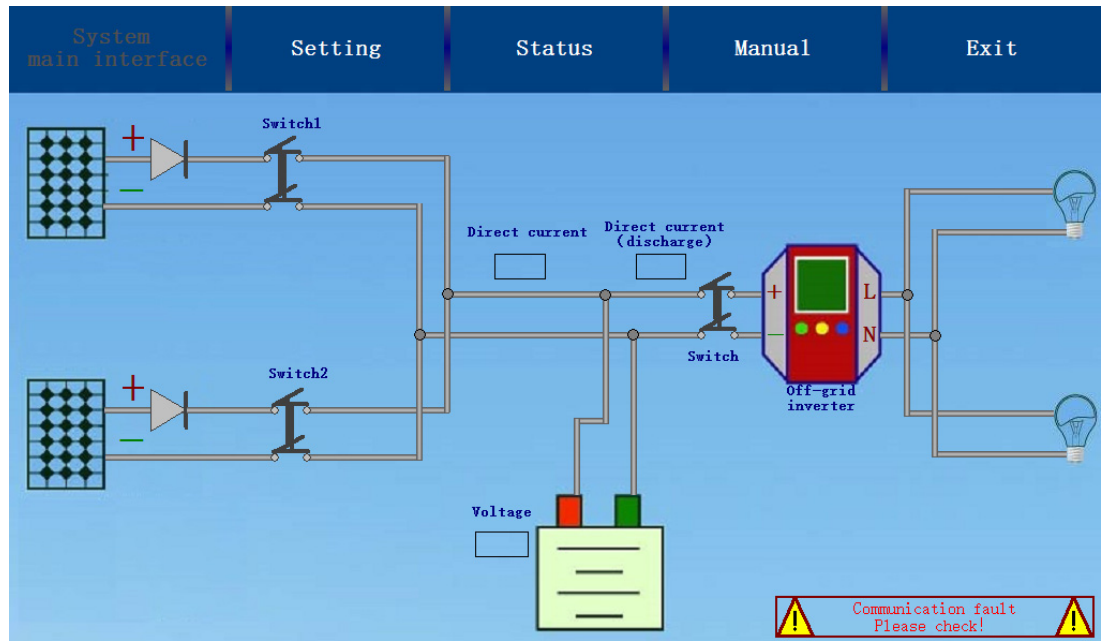
Figure 7. The interfaces of monitoring and parameter adjustment of PV power generation.